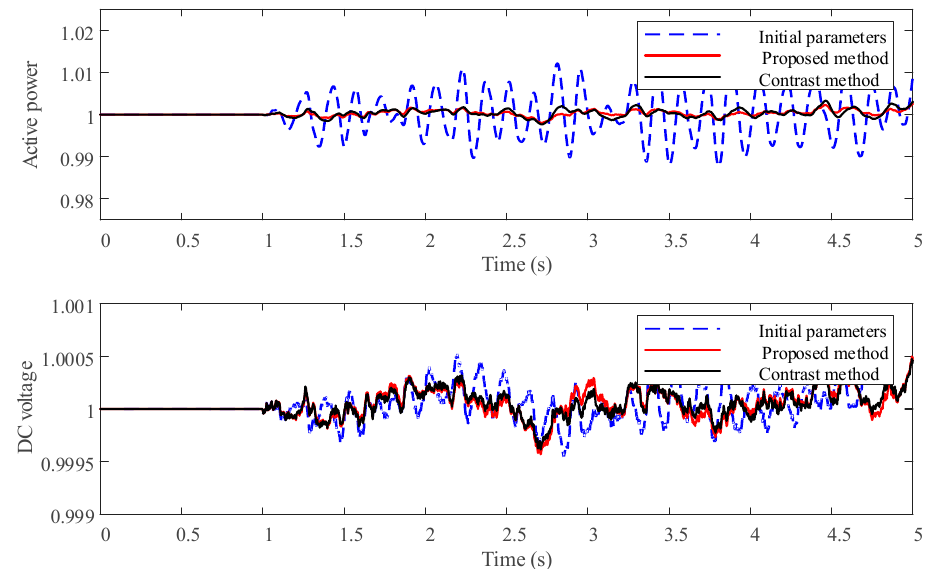
Figure 7. Active power and DC voltage of the PV-VSG with random perturbation.